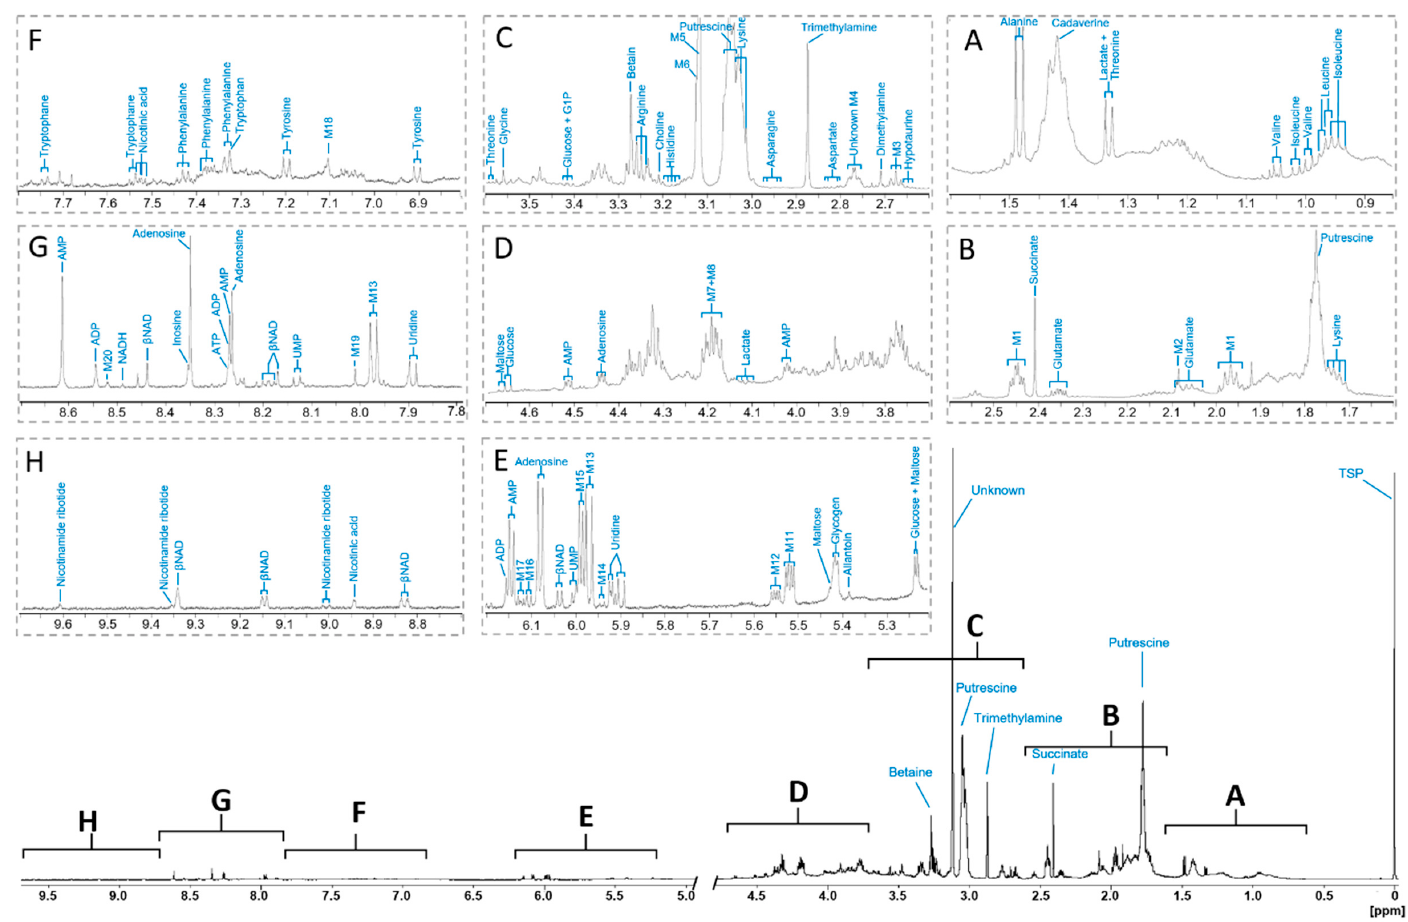
Figure 1. Representative 1 H NMR spectrum of Dreissena polymorpha whole-body polar extract. Portions of the spectrum ( A – E ) are displayed and scaled according to the highest peak to improve readability. Only the most identifiable signals on the spectrum are labelled by their corresponding metabolite chemical name. Signals corresponding to unknown signals with 1 H, 13 C or 31 P correlations are identified as M1 to M20. Detailed list of all identified signals in this spectrum and corresponding metabolites is provided as a Supplementary File. The detailed list of identified metabolites is provided in Table 1. TSP (3-trimethylsilyl 2,2,3,3-d4 propionate): internal reference (0 ppm).